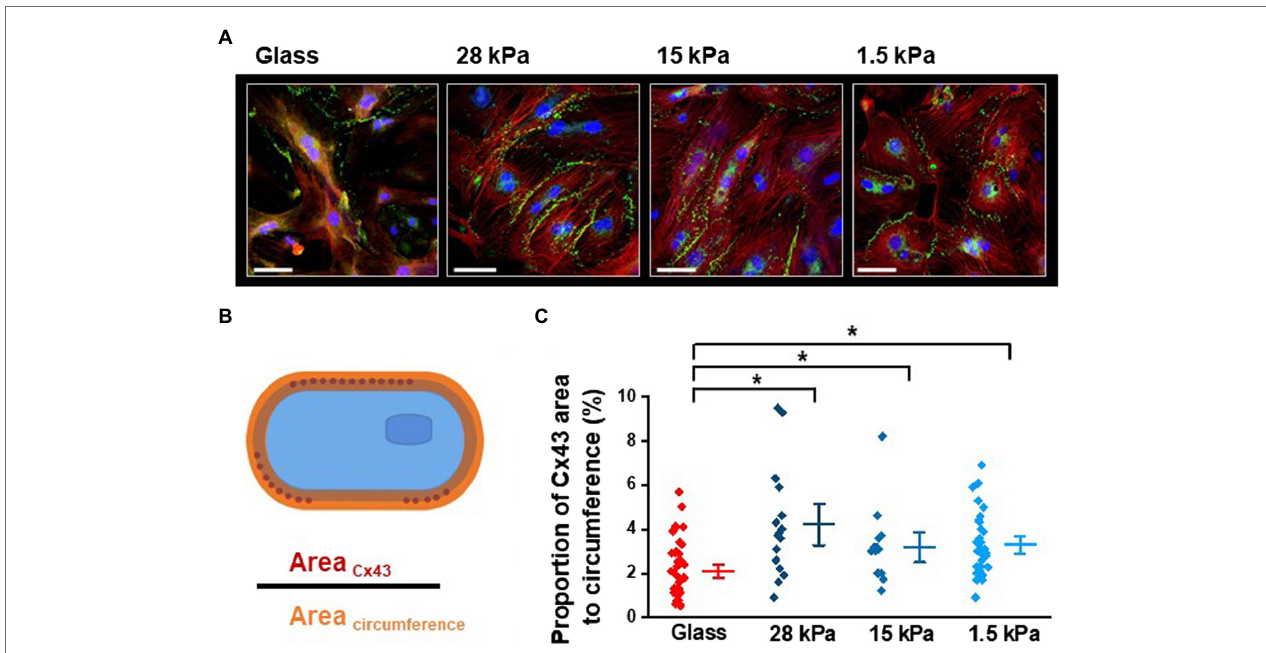
FIGURE 5 | Influence of different growth surface stiffnesses on Cx43 expression in iPSC-CMs. (A) Representative images showing Cx43 expression in green and nuclear signal in blue. Cx43 is characteristically located at the cell borders in iPSC-CMs, but is also expressed in the perinuclear regions (SB = 50 μ m). (B) Illustration of the quantitative analysis of Cx43-occupied area of the cell membrane in relation to the area of the entire sarcolemma. (C) Statistical evaluation of the proportion of Cx43-occupied area to the circumference revealing enhanced sarcolemmal expression of Cx43 in iPSC-CMs grown on soft surfaces compared to glass. Glass: n = 40; 28 kPa-PDMS: n = 16; 15 kPa-PDMS: n = 14; and 1.5 kPa-PDMS: n =